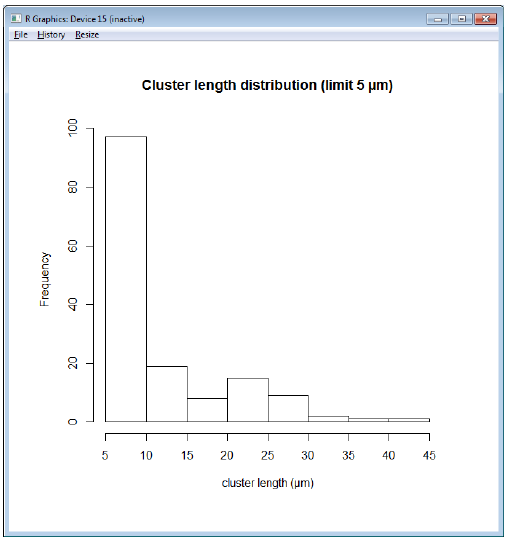
Figure 7: Largest cluster found in the specimen. specimen is depicted in increasing zoom levels from left to right. The location of the currently observed cluster is high- lighted with a rectangle and the chemical composition of the cluster is indicated by using different colours in a plot.